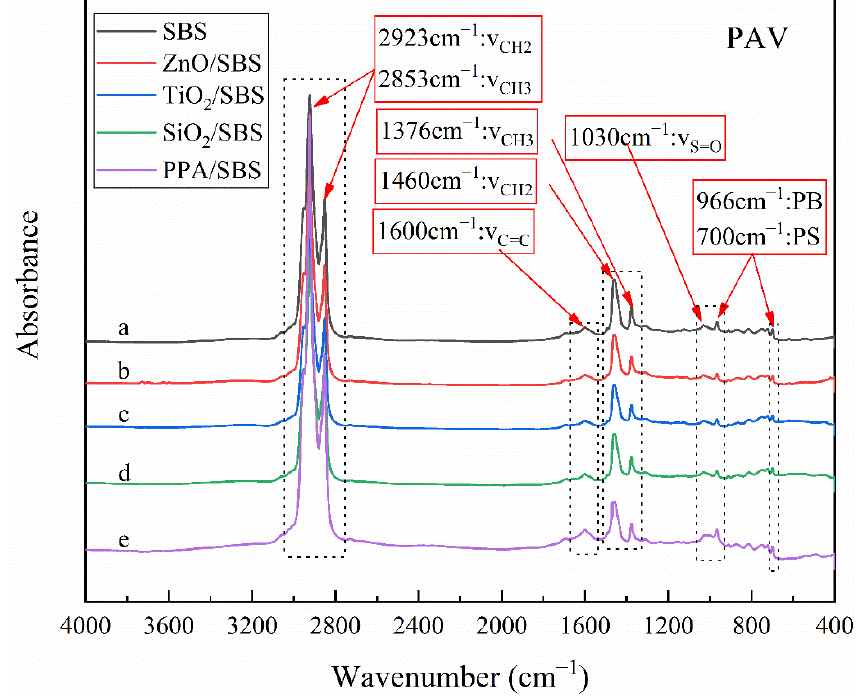
Figure 7. Infrared spectra of different high content SBS composite modified asphalts under a PAV aging state. aging